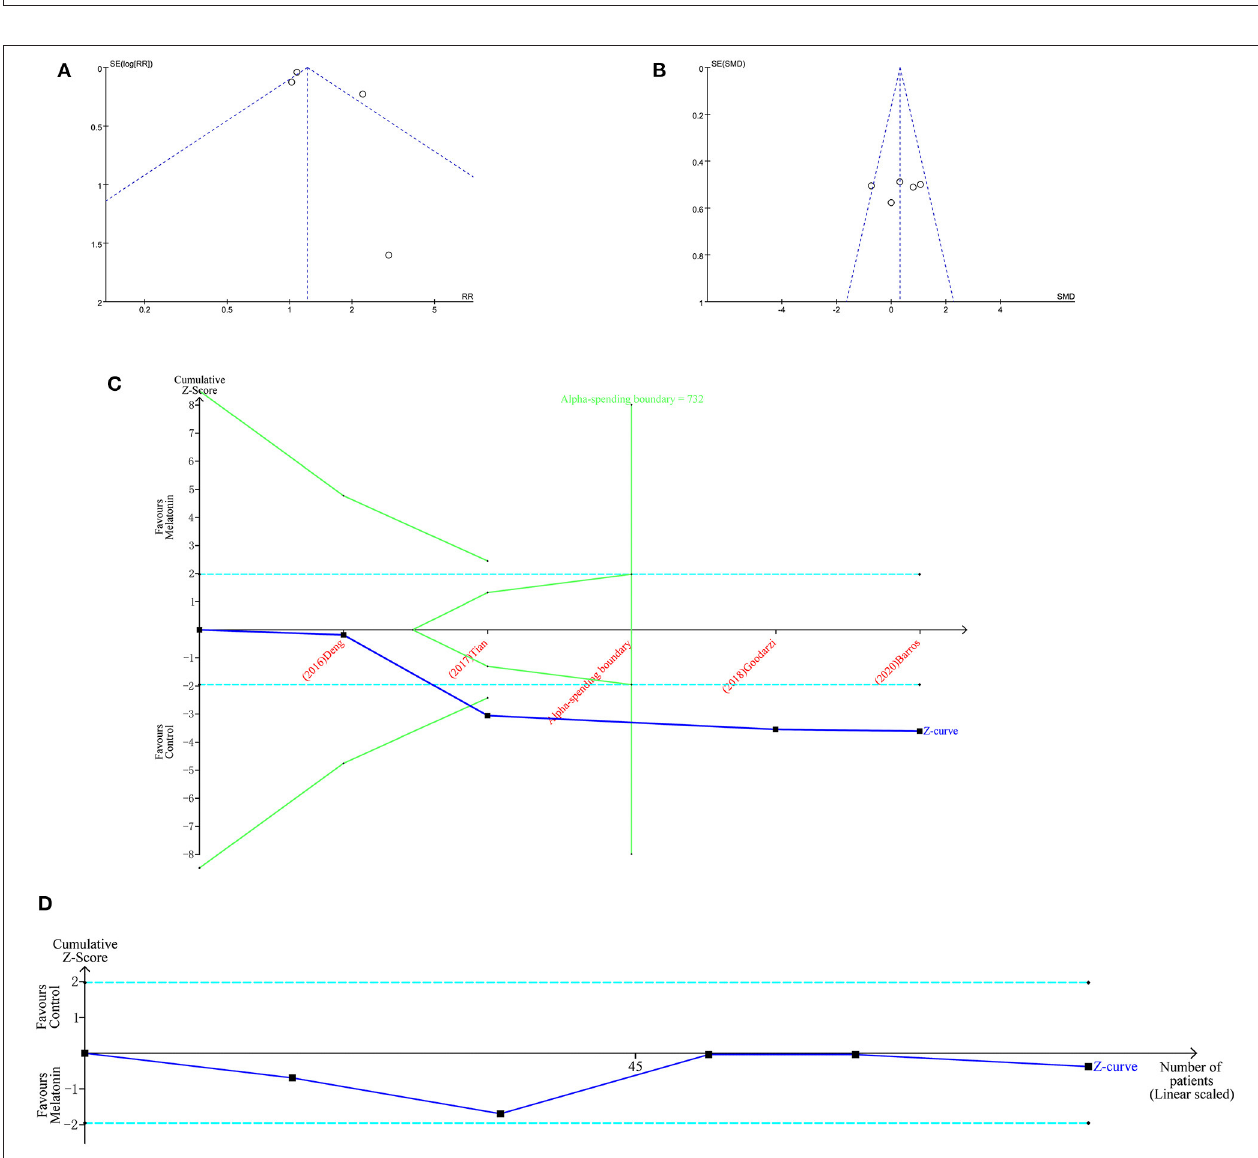
FIGURE 2 | Cleavage rate analysis of the culture droplet subgroup and the culture well subgroup yielded I 2 = 0%. (C) SMD for implanted exogenous MT effects on ovulation rate and fertilization rate. (D) RR implanted exogenous MT effects on cleavage rate, blastocyst rate, and pregnancy rate. (E) Implanted exogenous MT effects on litter size.